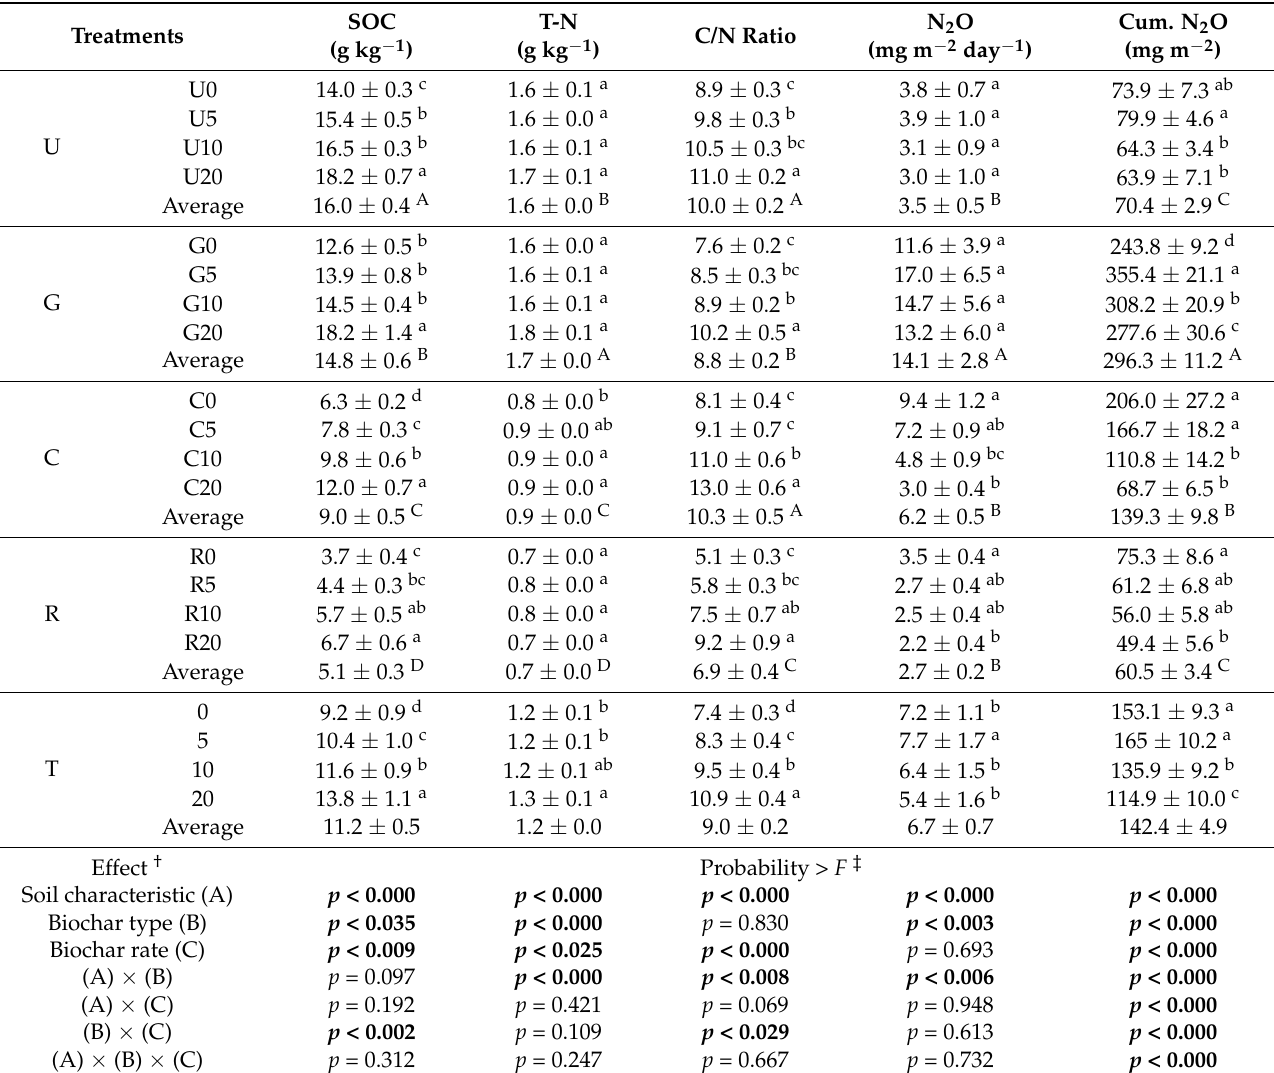
Table 4. SOC, T-N, C/N ratio, N 2 O emissions, and cumulative N 2 O emissions according to soil characteristics after 49 days of incubation